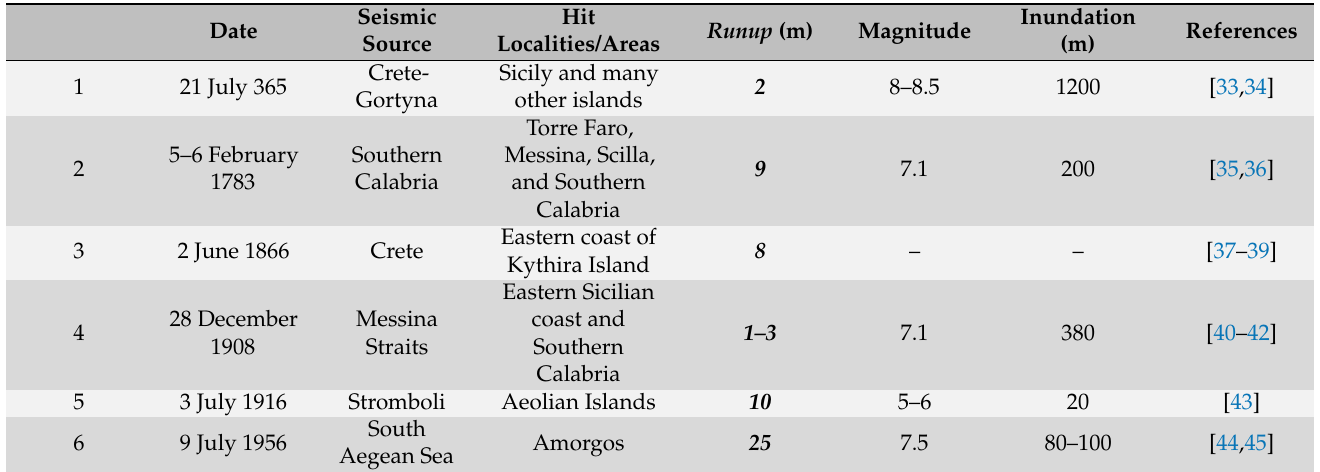
Table 1. Main tsunamigenic events in the central-eastern Mediterranean Sea (Euro-Mediterranean